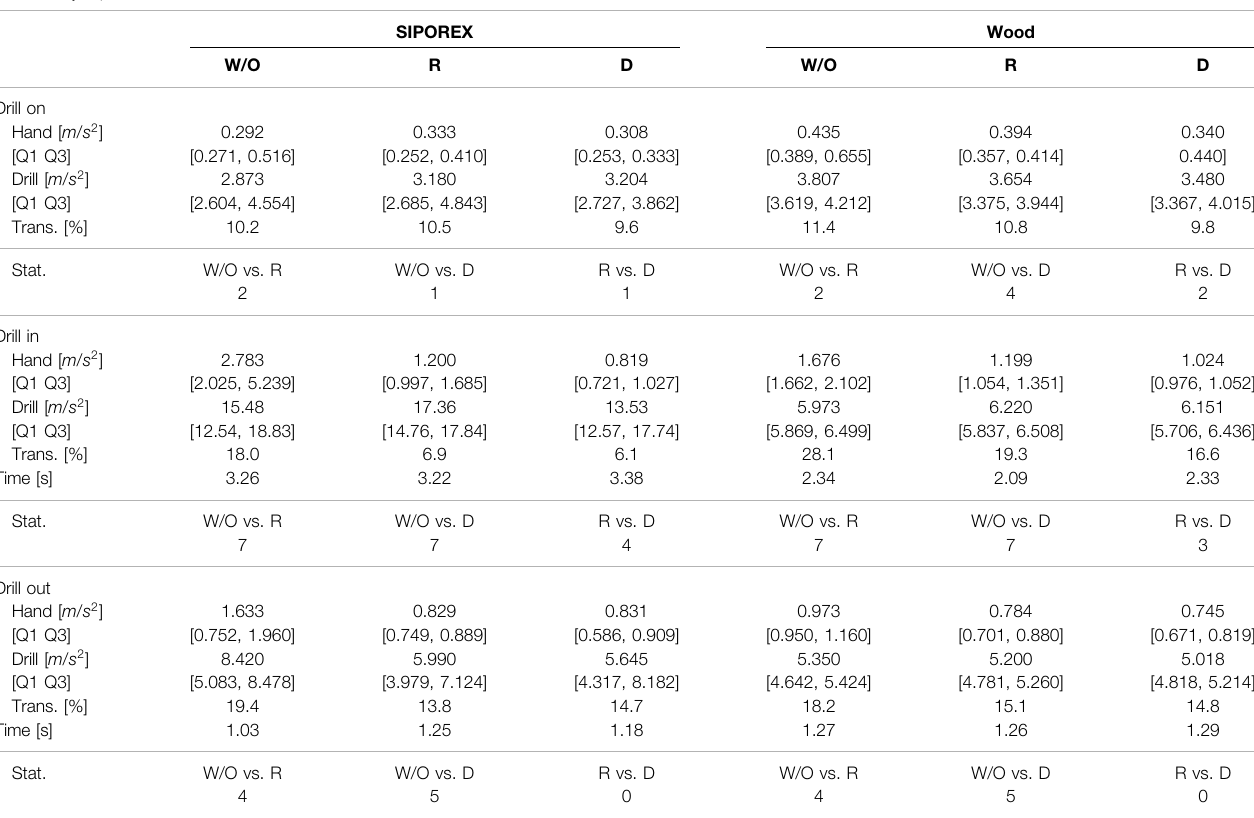
TABLE 1 | Experimental